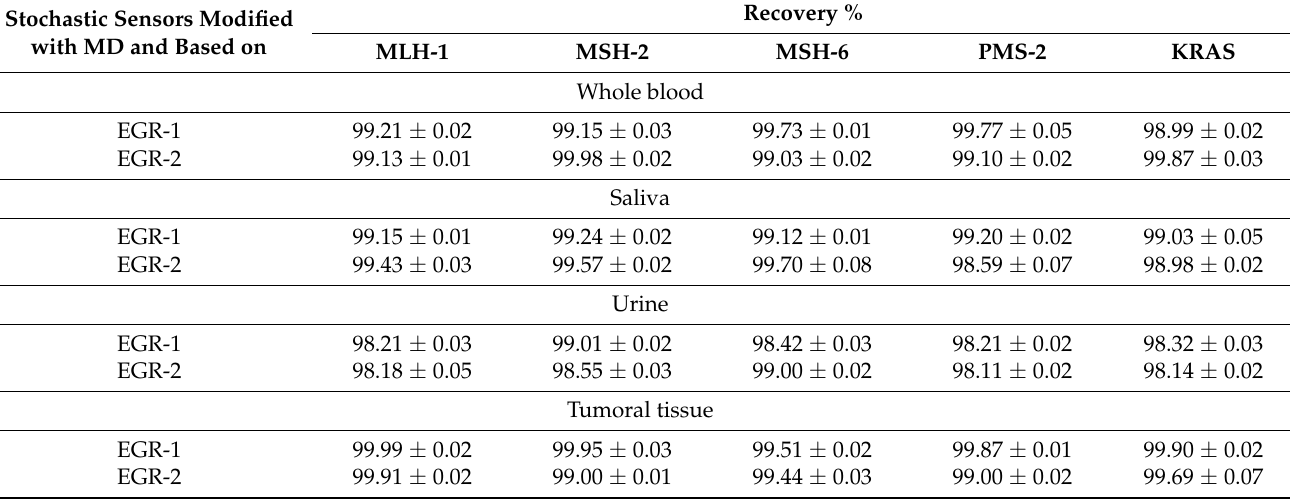
Table 3. Recovery tests for the assay of MLH1, MSH2, MSH6, PMS2 and KRAS from biological samples (N =